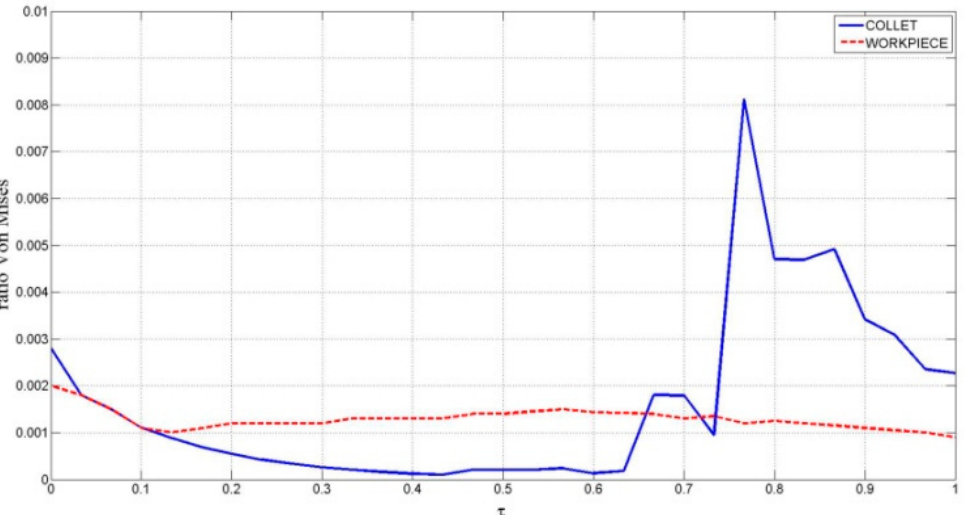
Figure 22. von Mises stress throughout contact between collet and workpiece.